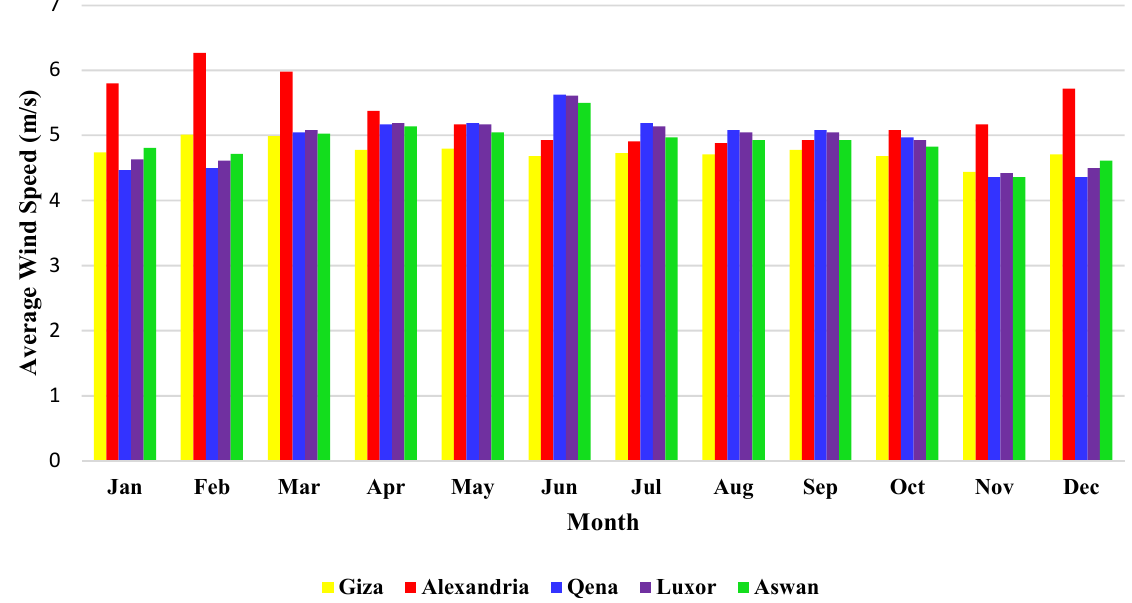
Figure 5. The average monthly wind speed data in Giza, Alexandria, Qena, Luxor, and